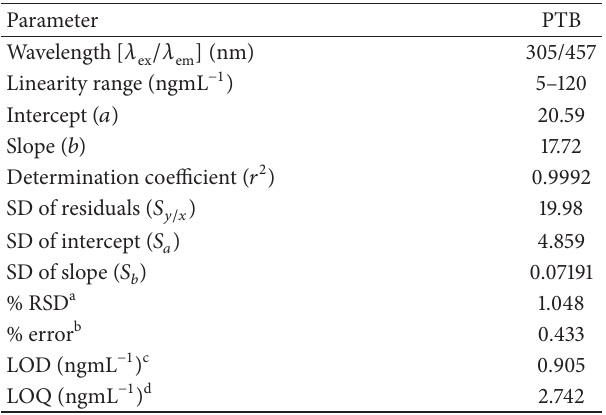
Table 1: Analytical performance data for the spectrofluorimetric quantitation of PTB.